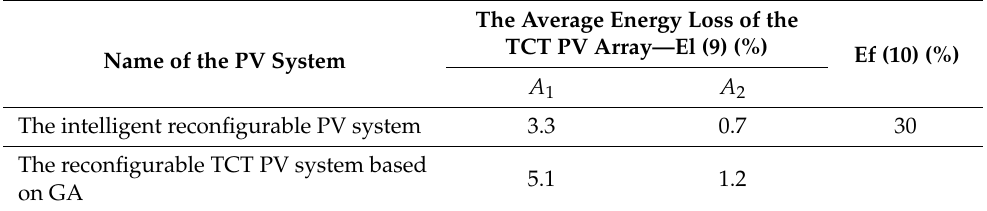
Table 2. Summary of average energy loses for the intelligent reconfigurable PV system and the reconfigurable TCT PV system based on